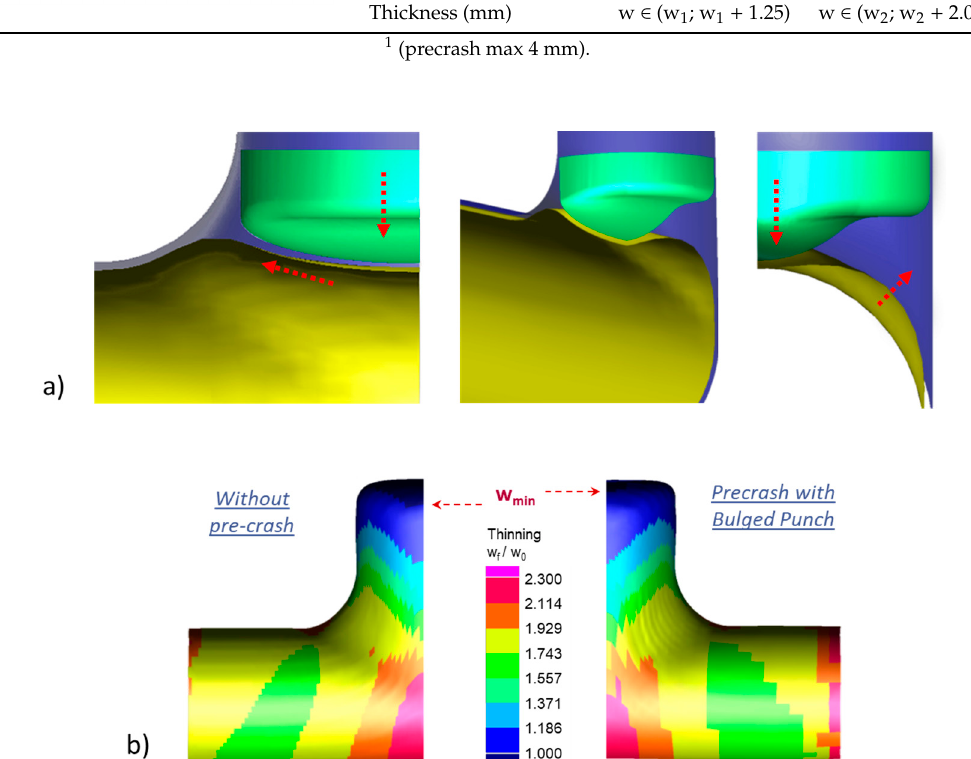
Figure 5. Precrash of the tube with bulged counter-punch. Effects on the ( a ) material flow ( b ) and thinning.